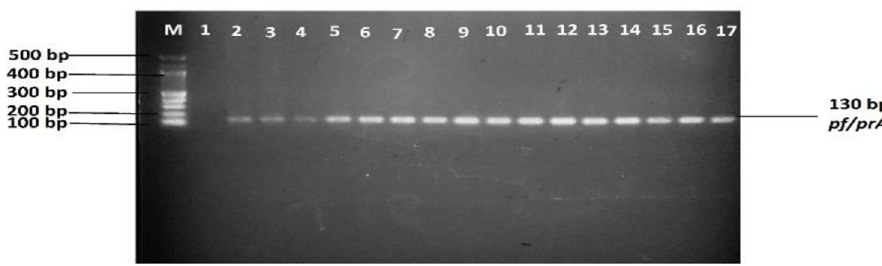
Fig 3. Agarose gel showing ERIC-PCR fingerprints of 15 AmpC- beta-lactamase E . coli isolates. M = 1Kb DNA molecular weight marker; Lane 1 = BCC; Lane 2 = BCB1; Lane 3 = LPVAW; Lane 4 = 6; Lane 5 = ZM2-B; Lane 6 = ZM1-B; Lane 7 = 22; Lane 8 = 11; Lane 9 = LM1-A; Lane 10 = 27; Lane 11 = ZB1-A; Lane 12 = LM1-C; Lane 13 = MCB2P; Lane 14 = MPCW; Lane 15 = MPCP; Lane 16 = LB1-A.